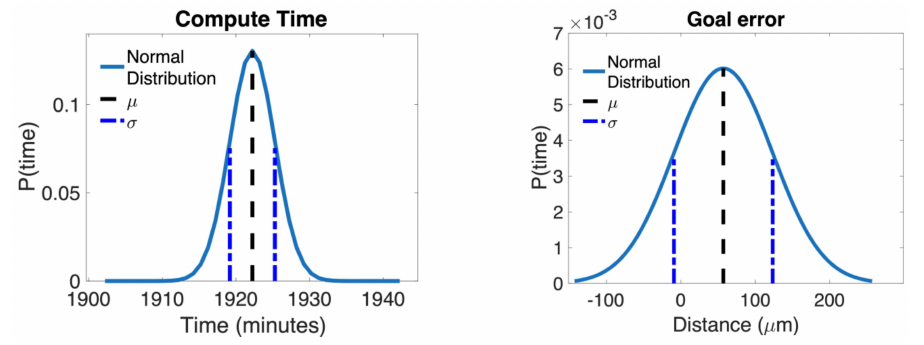
Figure 21. Time and goal